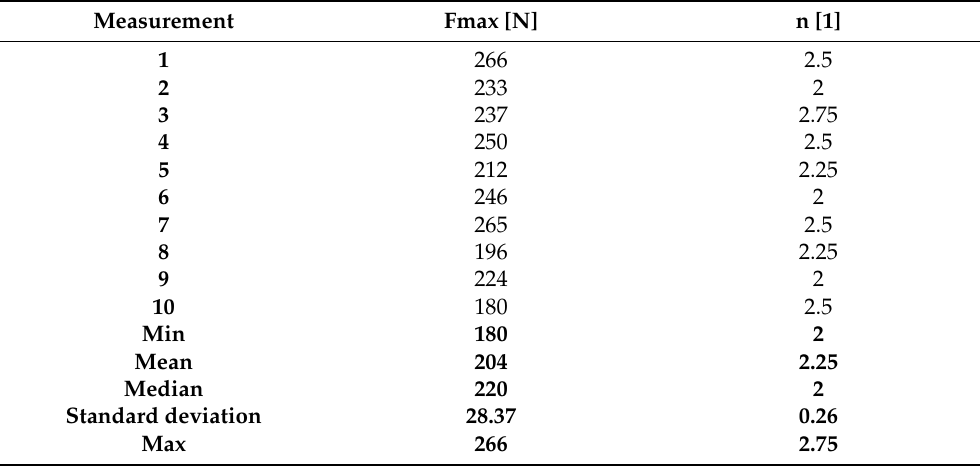
Table 4. Maximum values of the measured axial force in individual measurements.